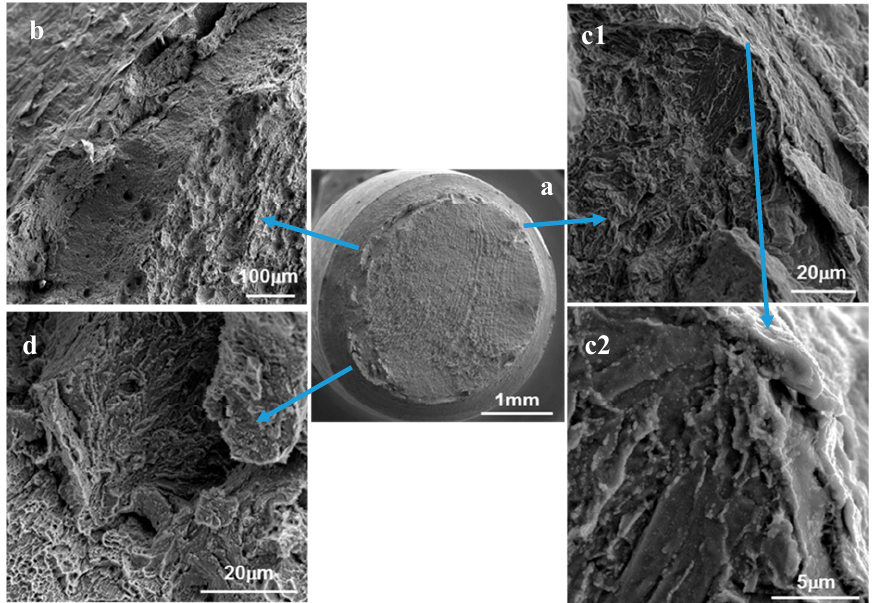
Figure 7. Fracture surface of the notched specimen (B02) with as received surface, tested in Pb at 350 °C, R1 (2 × 10 − 6 m/s); ( a ) general view, ( b ) twin shear cracks connecting the ductile fracture in the centre and the notch root, ( c1 ) cleavage-like facet of LME crack initiating from the notch and ( c2 ) its detail, ( d ) secondary cleavage-like facet of LME initiating from the shear crack tip.